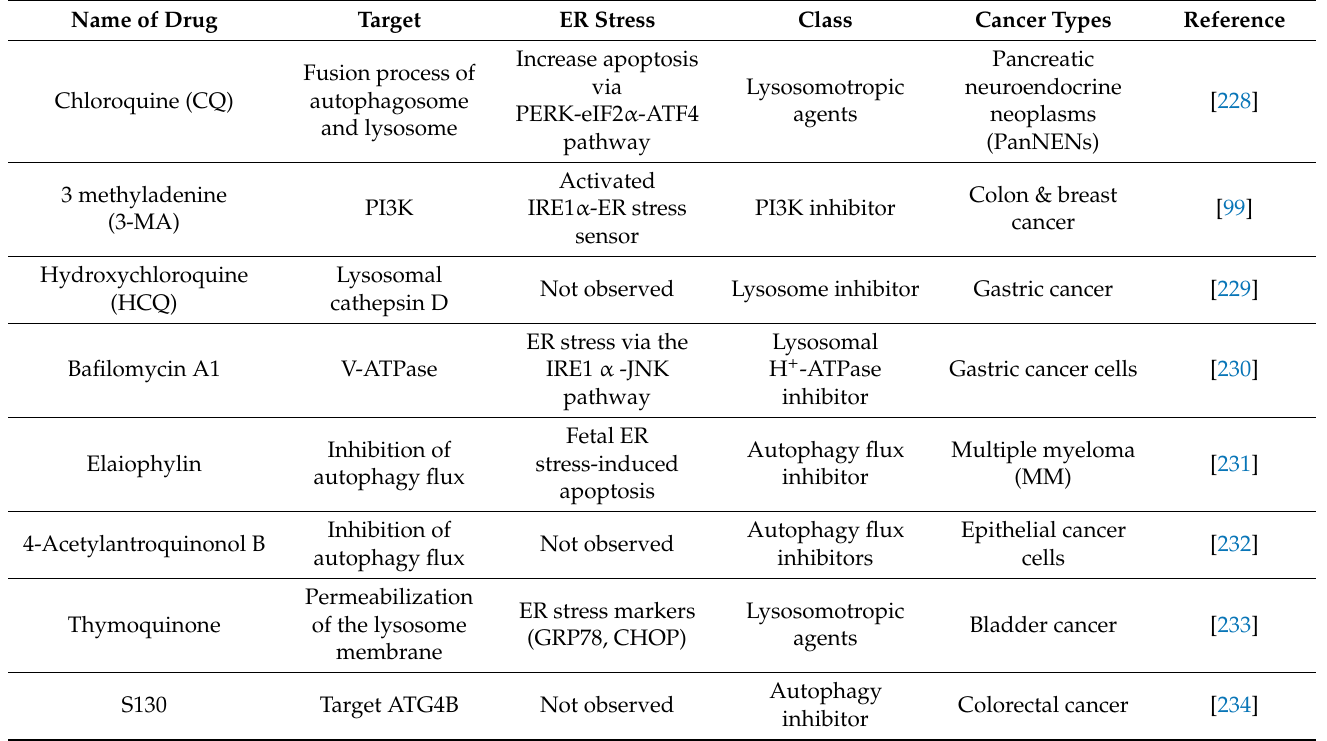
Table 3. Autophagy inhibitors intersecting with ER